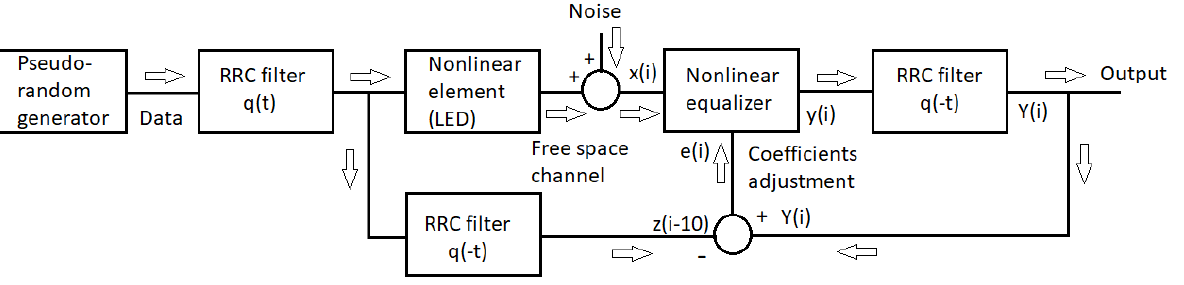
Figure 1. Block schematic of the transmission system in the training mode.